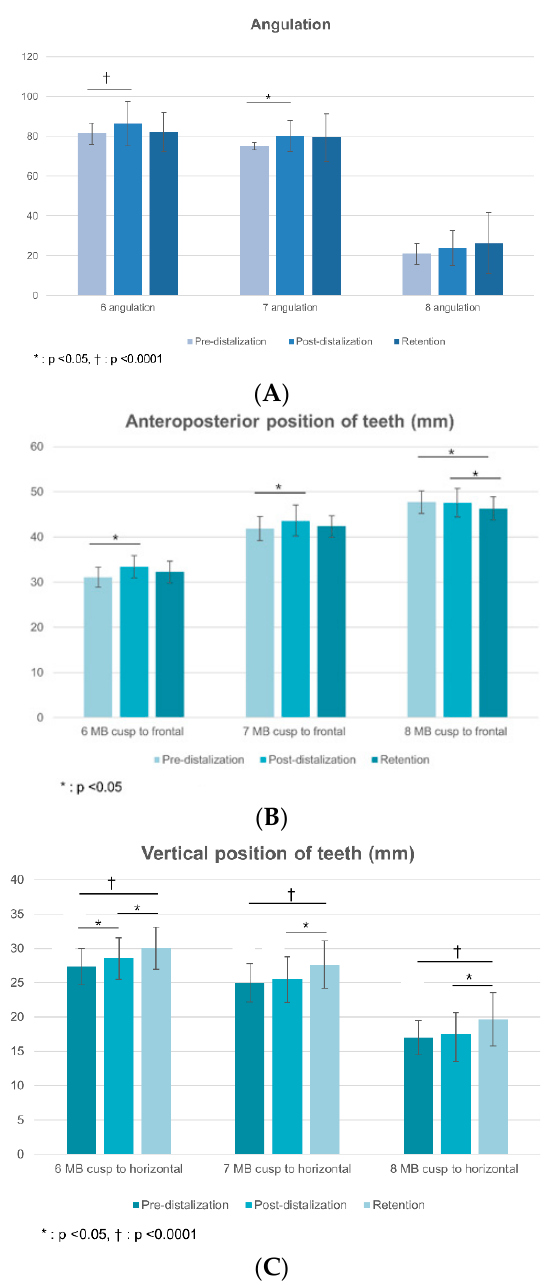
Figure 5. Bar graphs of angulation and frontal and horizontal positional changes at predistalization, postdistalization, and long-term retention in the treated group. ( A ) Angulation. ( B ) Frontal positional change. ( C ) Horizontal positional change. Table 3. Changes in post-distalization and long-term retention of the treated